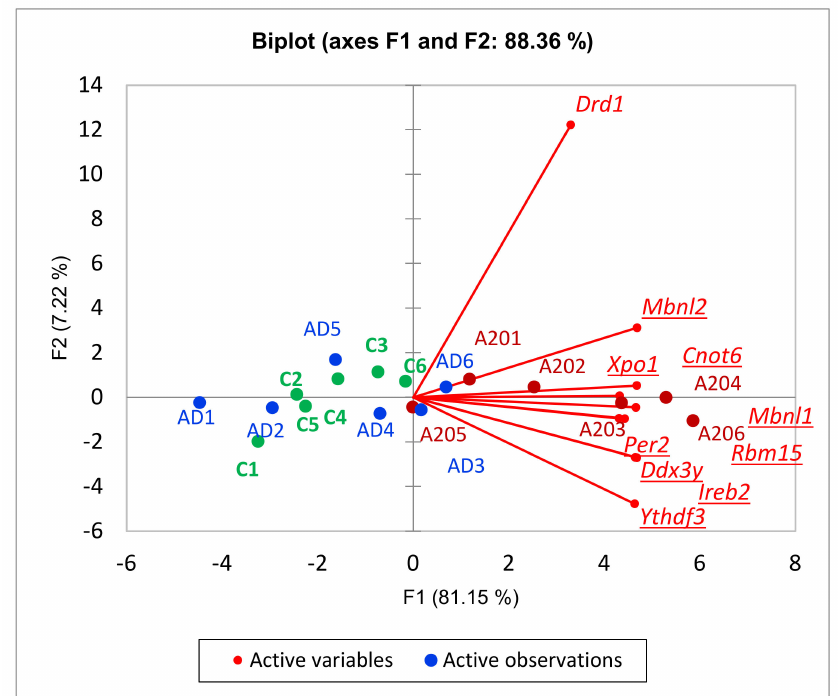
Figure 12. RNA-binding DEG subcluster within 149 cAMP-mediated positive A20 DEG cluster (Figure 10). Drd1 included, underlining significant correlation with these DEGs. Per2, Rbm15 are known transcriptional repressors (see the text). H0: random distribution of samples across 2 plot halves, p -value < 0.0045 (binomial test). Underlined gene names signify